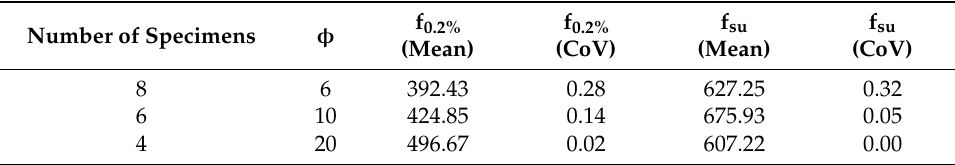
Table 2. Beams DB1 and DB2: existing and new strengthening bars diameter ( φ ), yield stress at